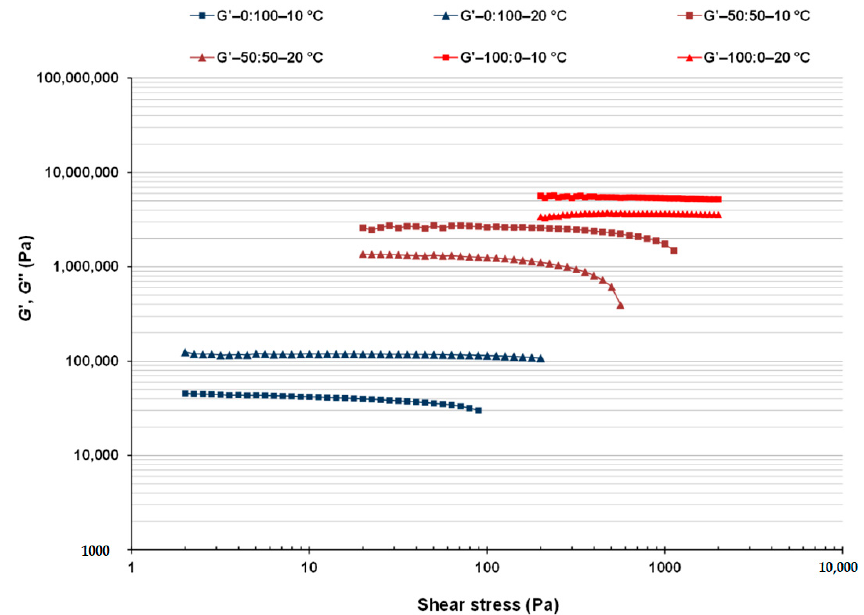
Figure 1. Storage modulus ( G ') as a function of the applied shear stress at 100:0, 50:50 and 0:100 formulated systems at 20 and 10 °C.